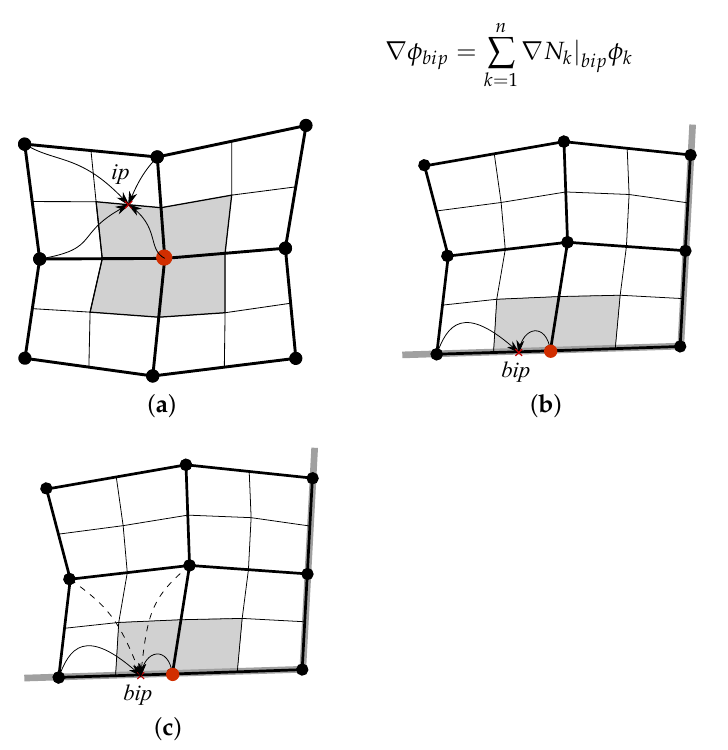
Figure 3. Demonstration of the interpolation process from the nodes of the element to an integration point associated with a dual volume (shaded in gray) for ( a ) interior integration point, ( b ) boundary integration point, and ( c ) boundary integration point associated with the evaluation of a